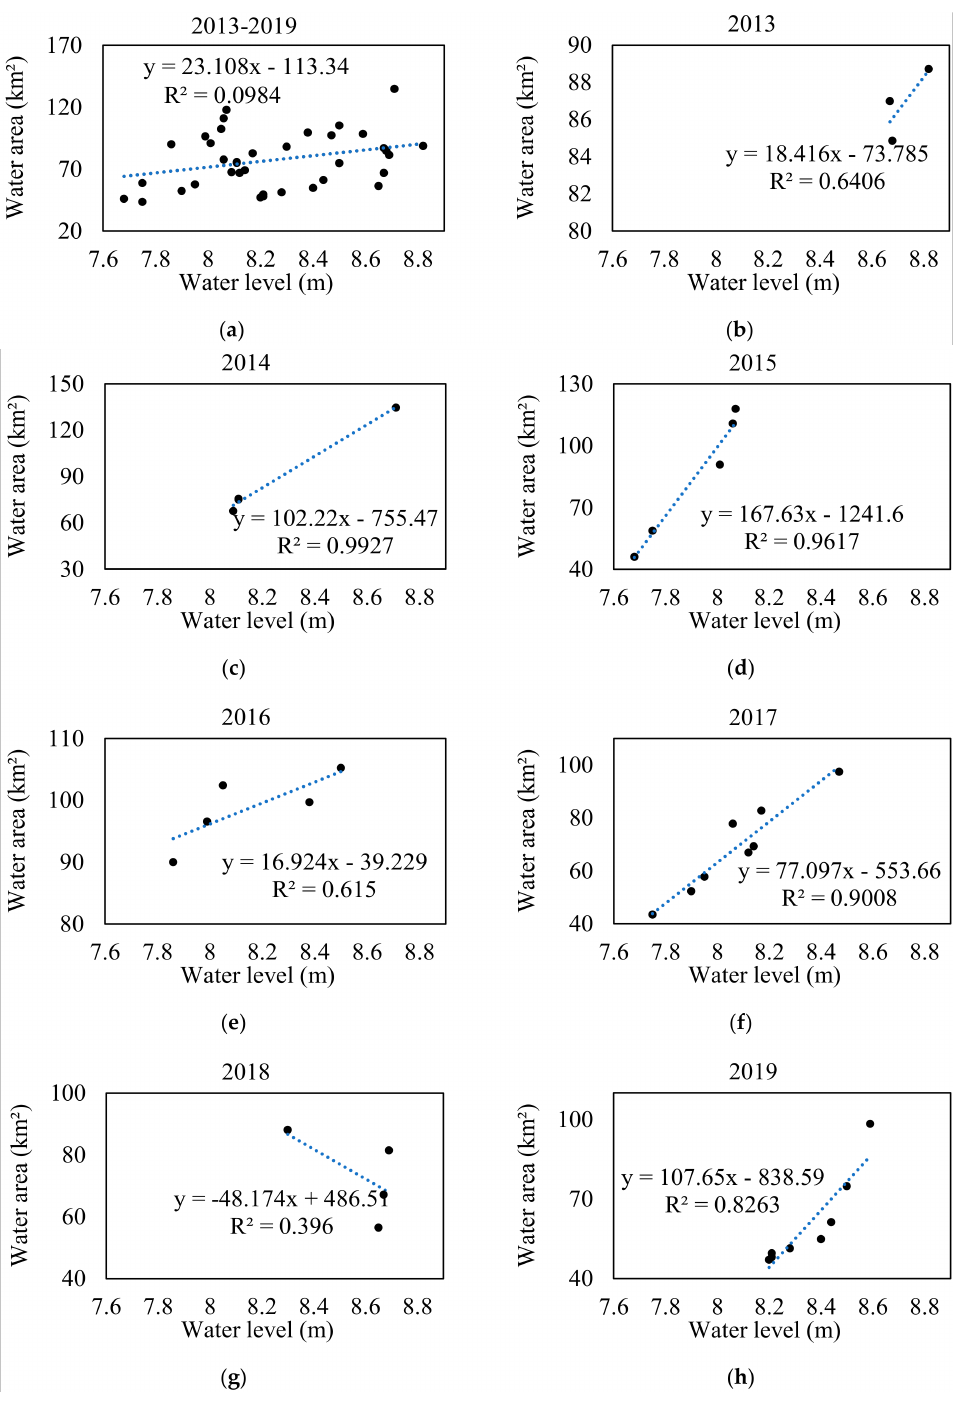
Figure 3. ( a ) Scatter plot of water level and water area from 2013 to 2019; ( b–h ) scatter plots of water level and water area during each